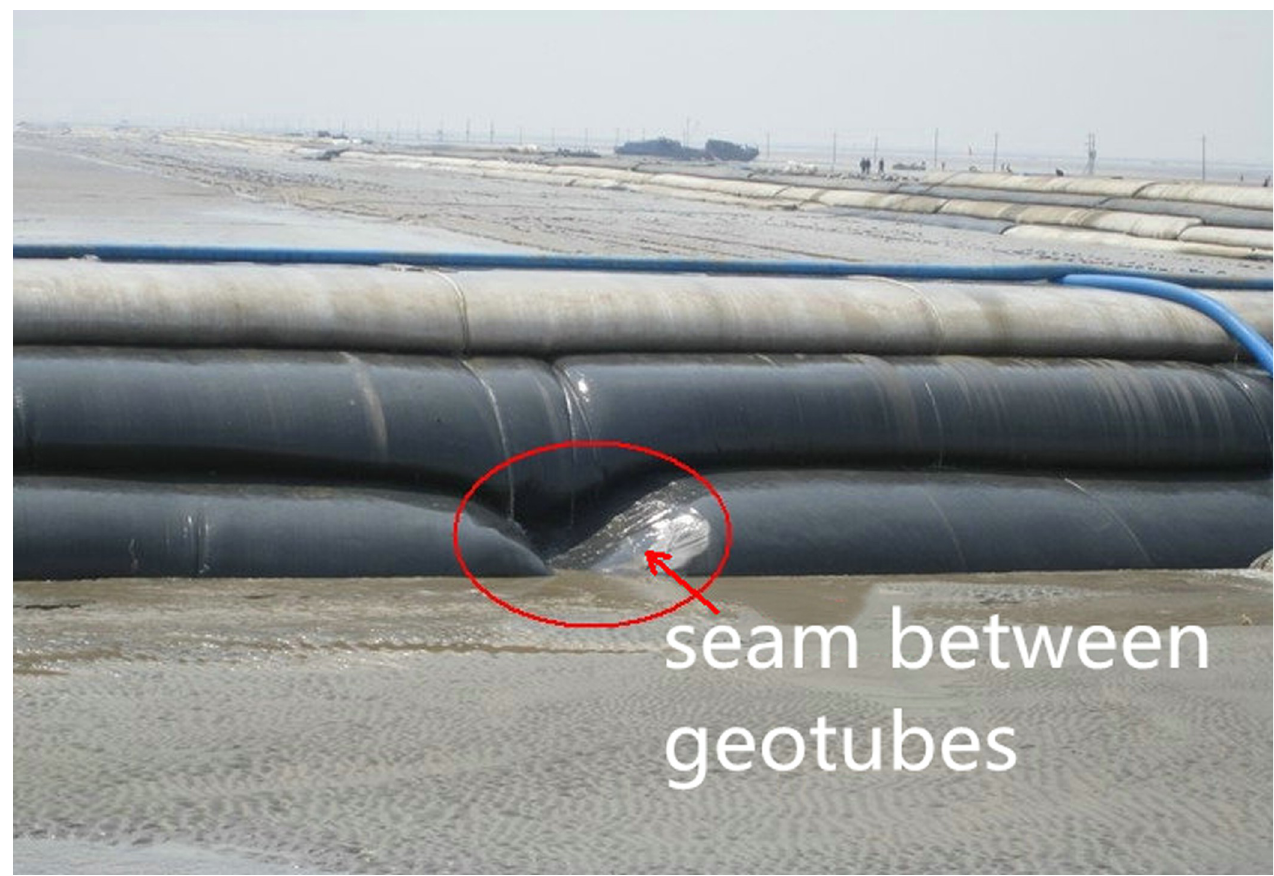
Fig 1. Joint seam between tubes in a geotube